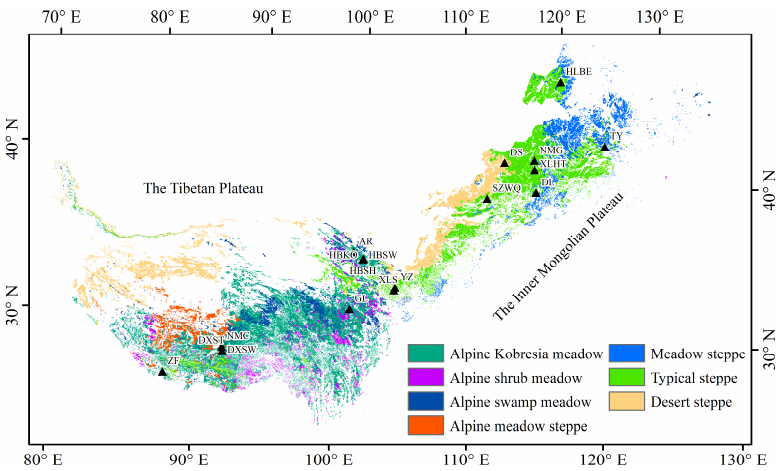
Figure 1. Spatial distribution of alpine and temperate grasslands in China [34]. Black triangles denote the 18 flux